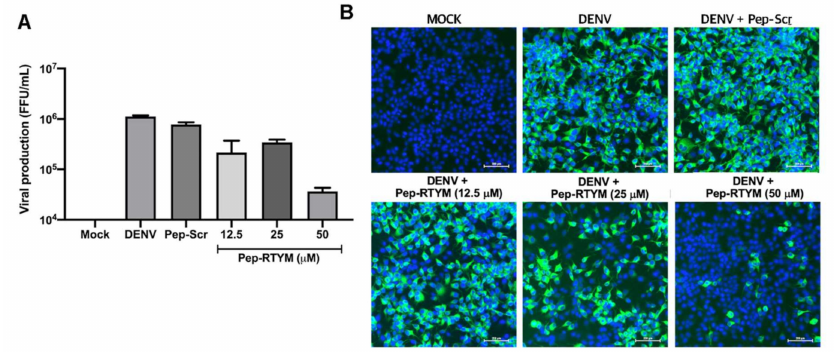
Figure 5. Inhibitory e ff ect of Pep-RTYM on DENV infection in infected hepatocytes. DENV2 was treated with Pep-RTYM at concentrations of 12.5, 25, or 50 µ M prior to virus infection in Huh7 cells. The inhibitory e ff ect of Pep-RTYM was determined at 48 h after infection by analysis of the level of decreased virus production ( A ) and the number of infected cells ( B ) compared to that of Pep-Scr using virus titration and immunofluorescence assay,